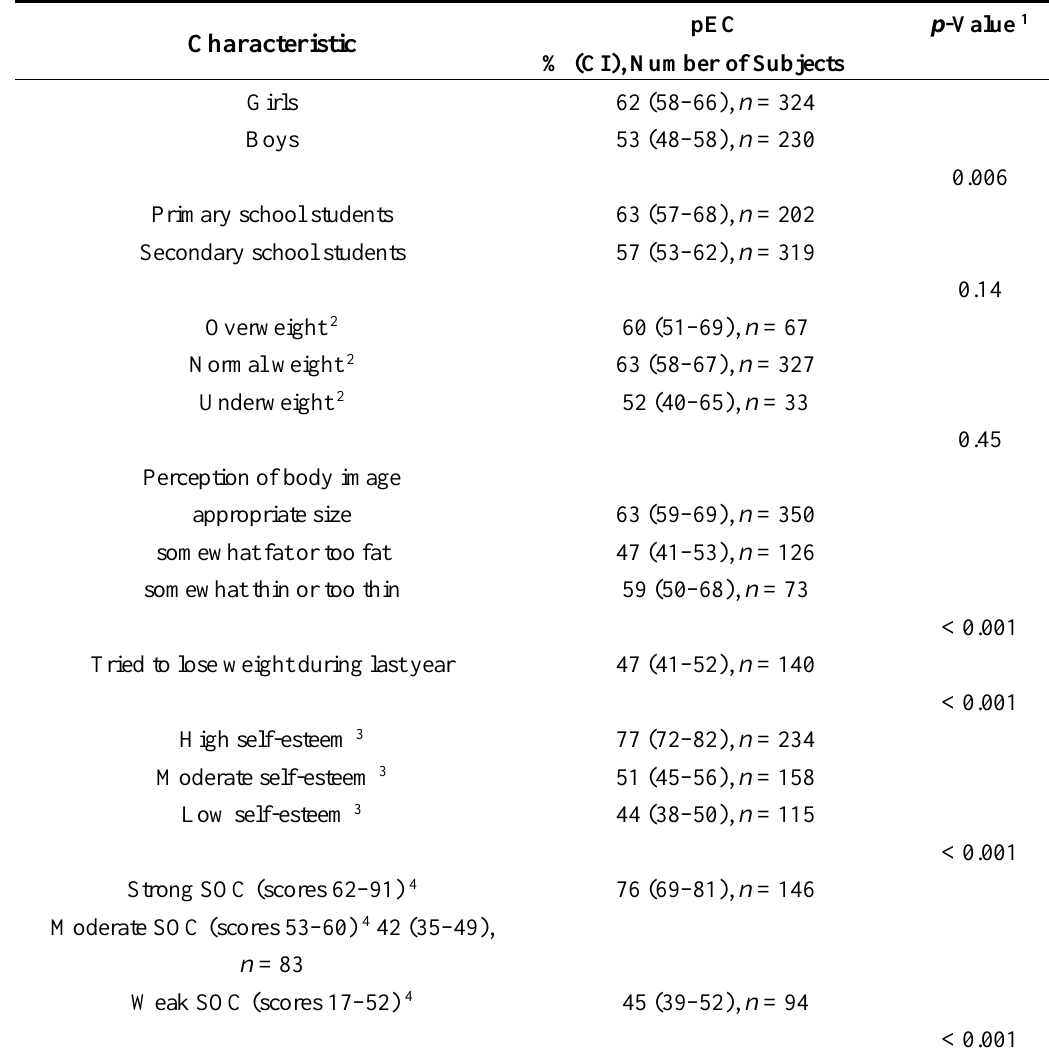
Table 2. Characteristics of the adolescents who scored high (scores ≥ 32 in the preliminary Finnish translation of the ecSatter Eating Competence Inventory 2.0) and were classified as “presumably eating competent” (pEC) ( n = 582, 58% of